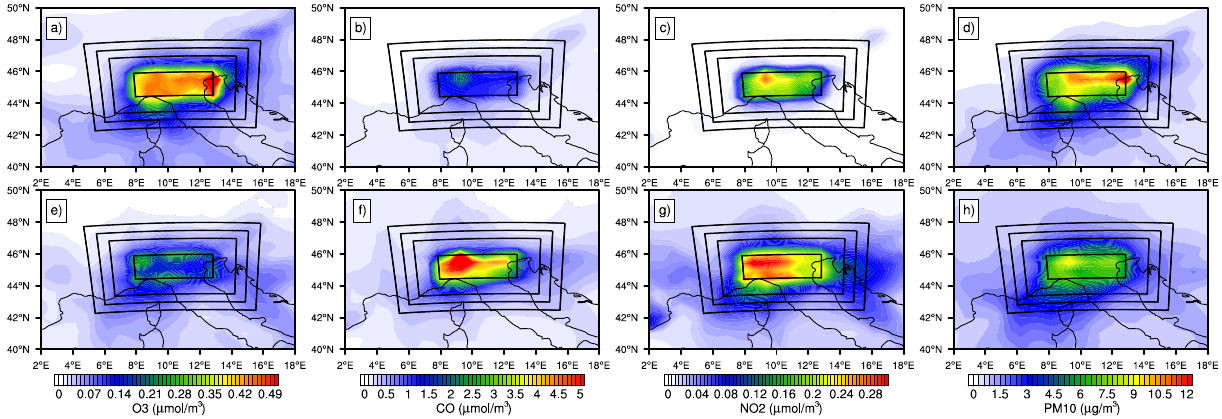
Fig. 2. Surface concentration of O3 from HR simulation (left panel) and the corresponding C HRr − C LR for 2005-06-17 06:00 UTC (right panel). This forcing term is applied only within the core region delimited by the internal box. Boxes are as in Fig. 1.